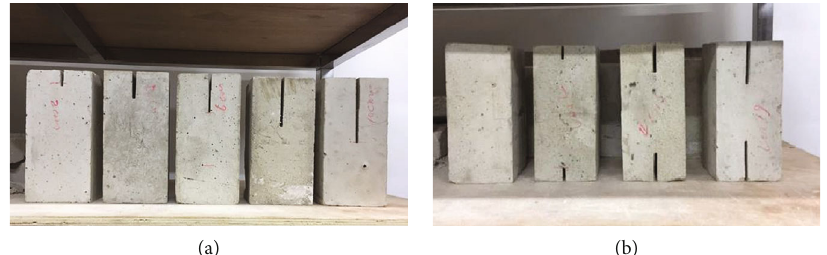
Figure 1: Rock-like specimens with di ff erent cracks: (a) specimens with unilateral crack; (b) specimen without crack and specimens with bilateral crack.